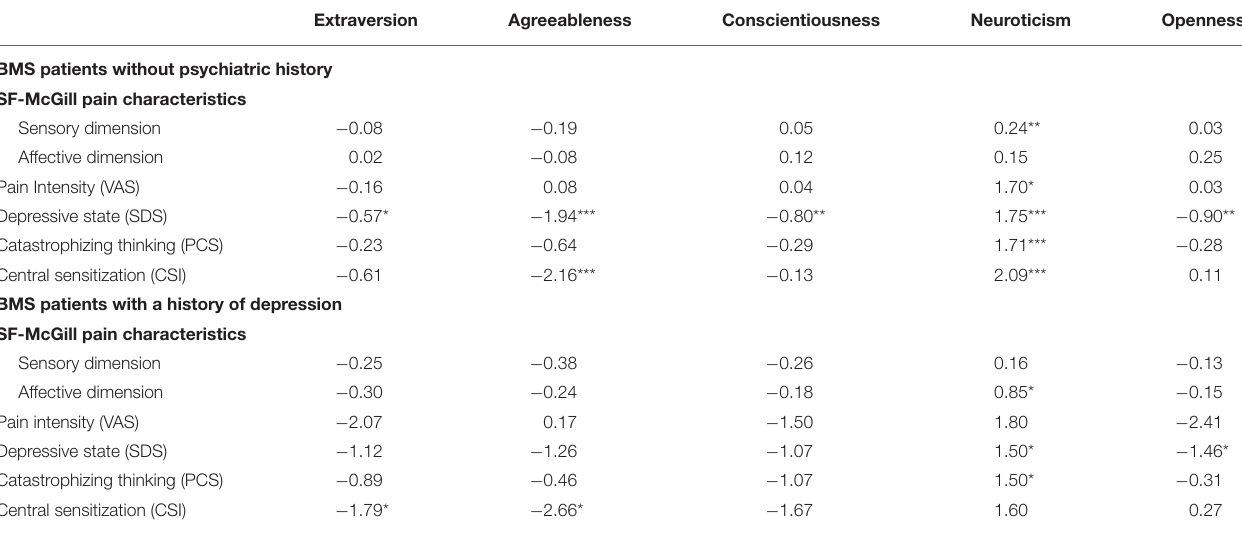
TABLE 3 | Impacts of personality on clinical measures (controlled for age, sex and illness